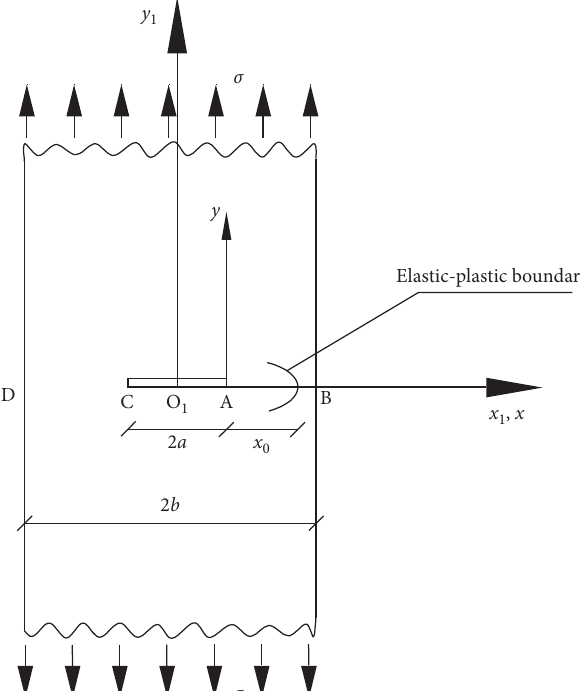
Figure 2: A center-cracked plate with finite width subjected to uniform stress σ along the y direction at